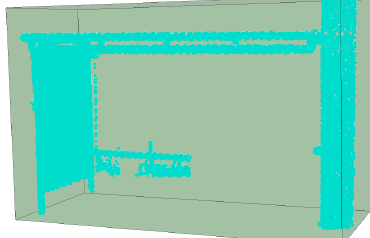
Figure 9. Bus space (bus stop A). Ground truth box (green square), estimated box (red square)